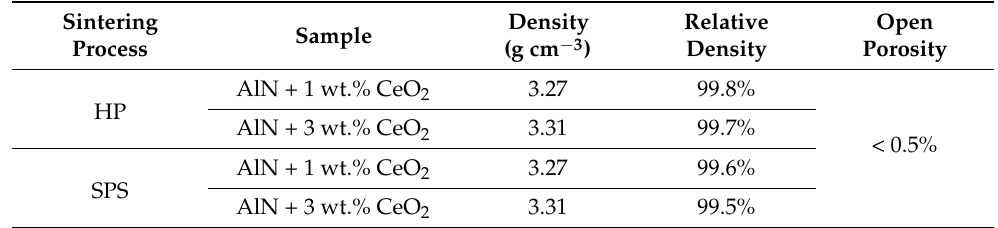
Table 3. Density of the sintered